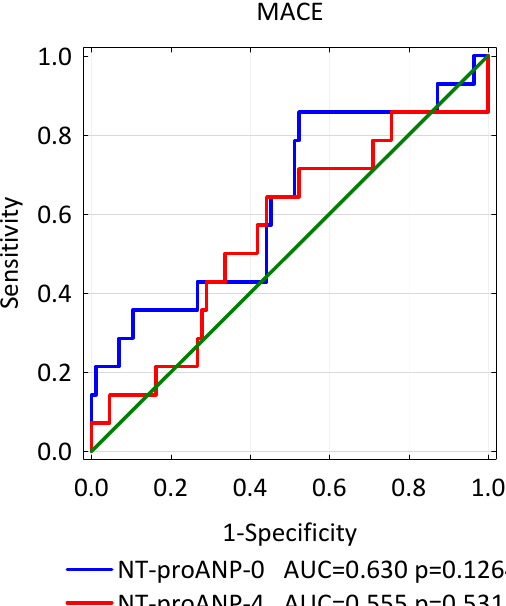
Figure 4. ROC curves–variables tested: the concentration of NT-proANP on admission to the hospital (NT-proANP-0) and on the 4th day of hospitalization (NT-proANP-4) in identifying patients at risk of MACE in the follow-up.